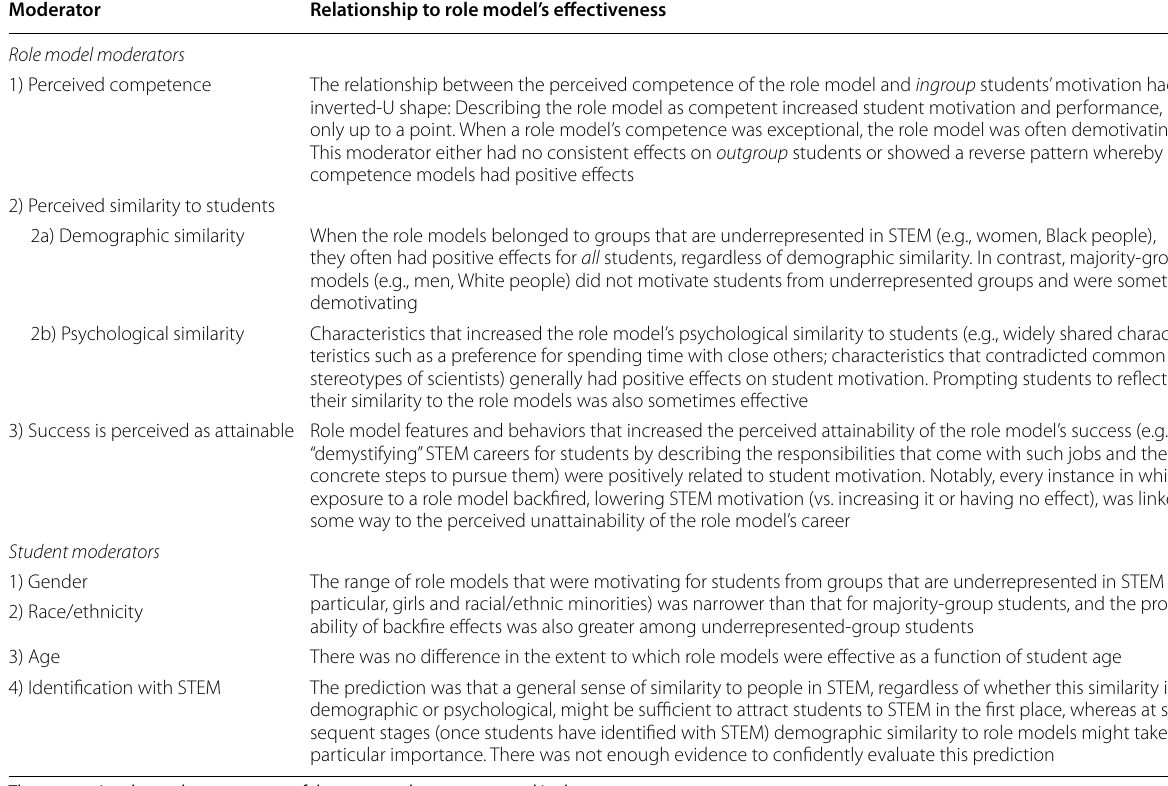
The summaries above gloss over some of the nuances that are presented in the text